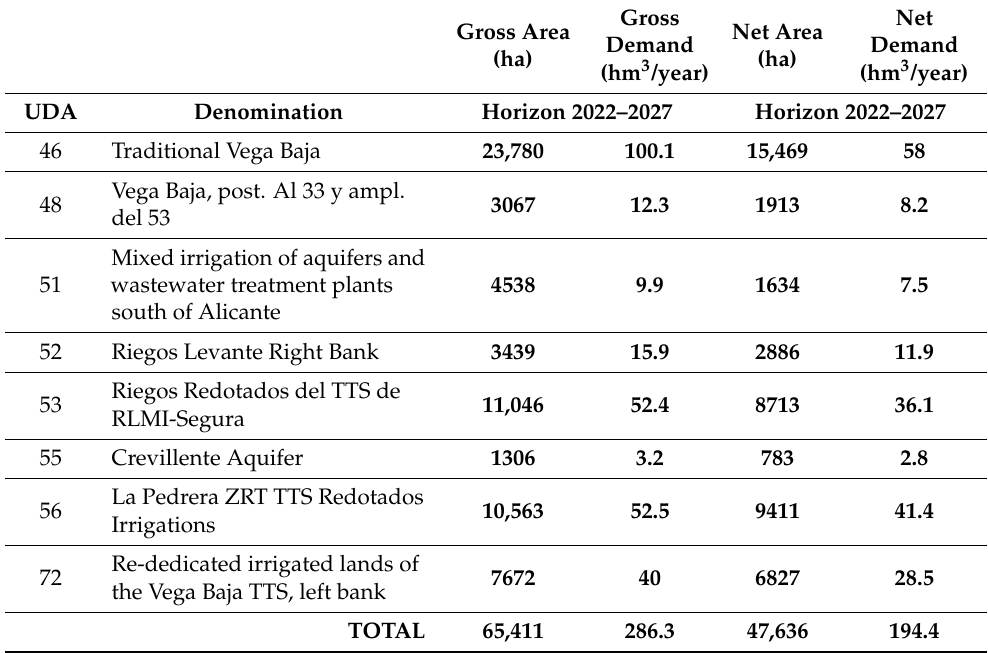
Table 6. Area (gross and net) and demand (gross and net) by UDAs belonging to the region of Bajo Segura (Alicante).